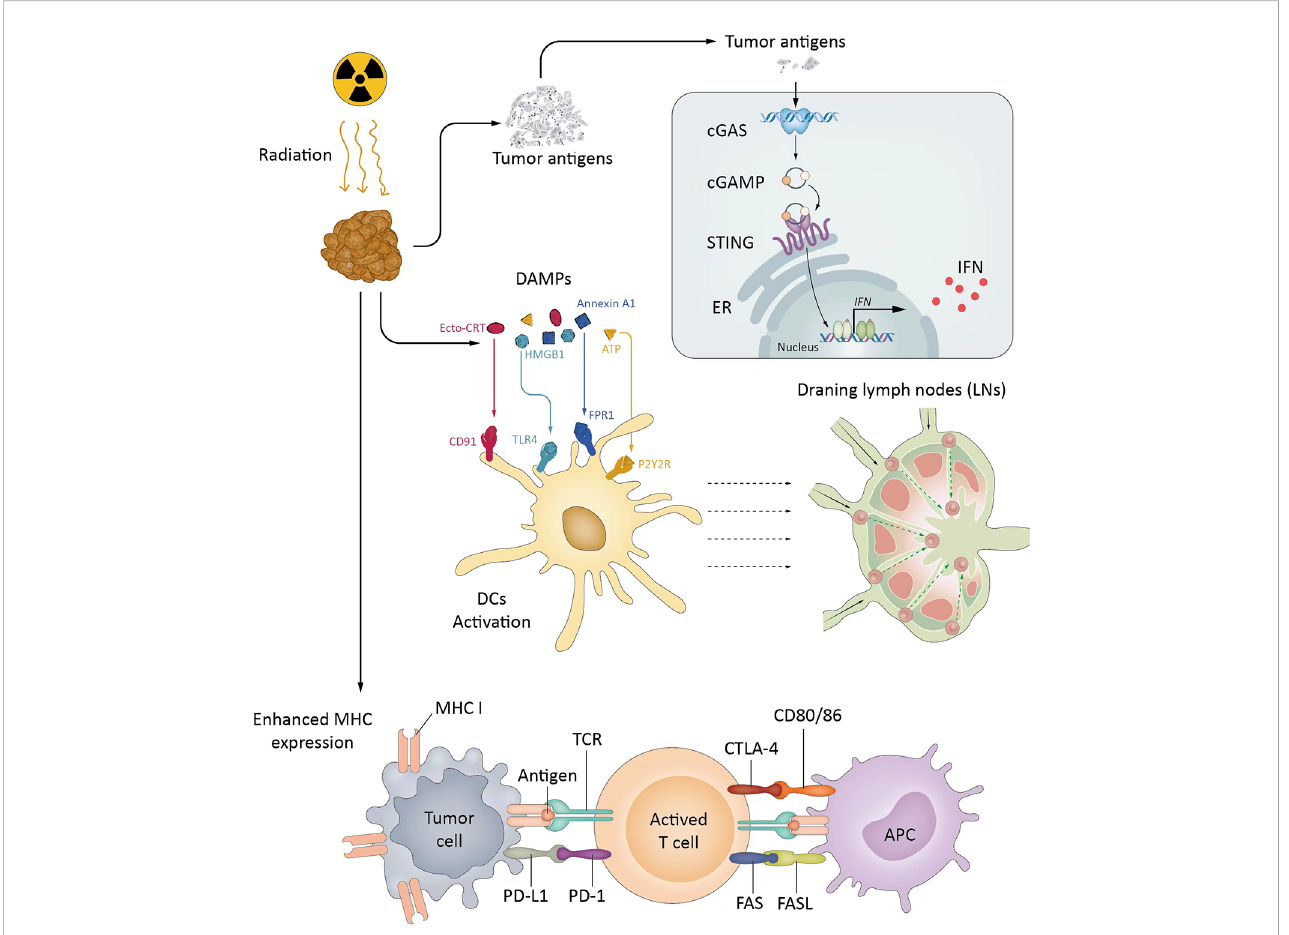
FIGURE 1 The synergistic effects of radiotherapy and ICIs. RT activates the cGAS/STING pathway, promotes APCs, and primes Tils into TME (cold to hot). RT increases MHC expression and changes the immunogenicity of tumors. ICIs reverse inhibitory signals and exhaustion pathways mediated by RT. cGAS, Cyclic guanosine monophosphate-adenosine monophosphate synthase; CTLA-4, Cytotoxic T lymphocyte-associated protein 4; IFN, Interferon; LN, Lymph node; MHC, Major histocompatibility complex; PD-1, Programmed death 1; PD-L1, Programmed death-ligand 1; STING, Stimulator of interferon genes; TAA, Tumor-associated antigen; TCR, T-cell receptor; Trex1, Three prime repair exonuclease